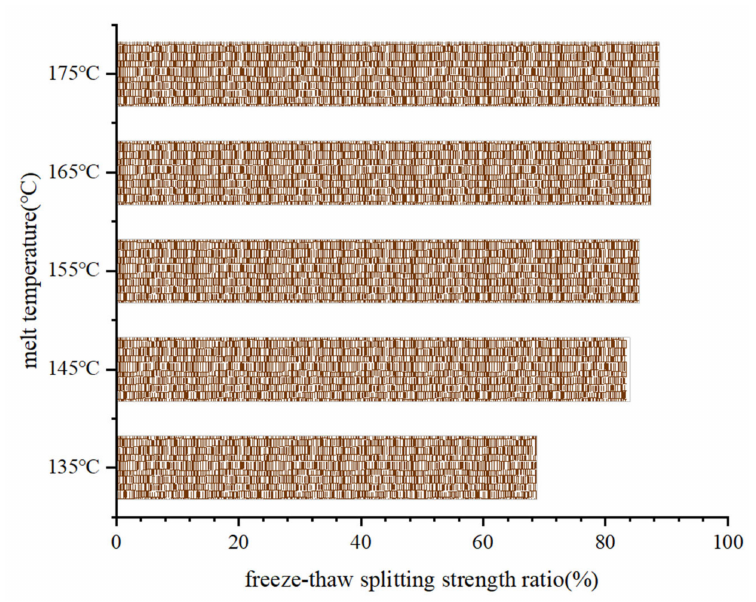
Figure 14. Results of the freeze-thaw splitting tests on the SMA-13 asphalt mixes with different melt